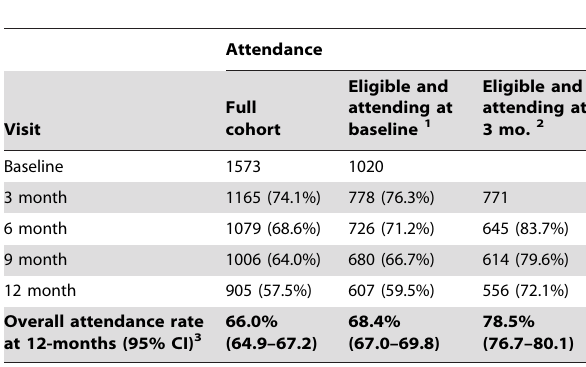
Table 1. Re-attendance among women eligible to enrol in a future microbicide